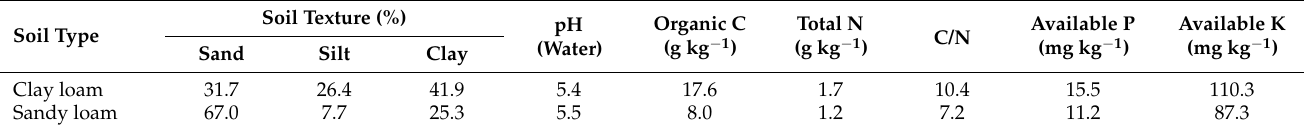
Table 1. Basic properties of the two soils